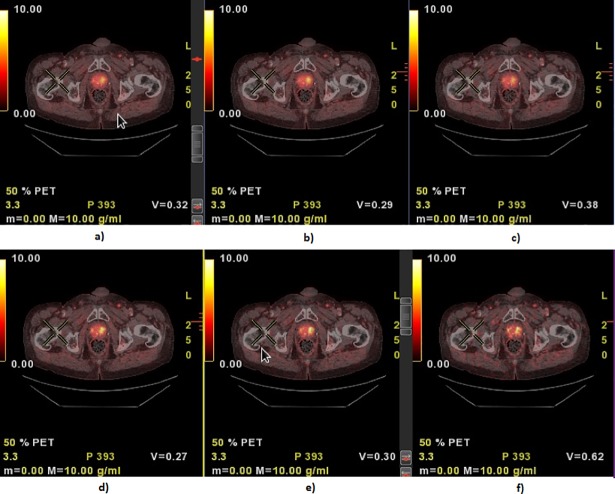
ACE-PET/CT with different acquisition times with VPHD and SharpIR.Transaxial PET/CT illustrating focal uptake in the left lobe of the prostate. (A, B, C) PET data reconstructed with VPHD 42% with 4, 2 and 1 minutes’ acquisition time, and (C, D, E) SharpIR 42% with 4, 2 and 1 minutes’ acquisition time.